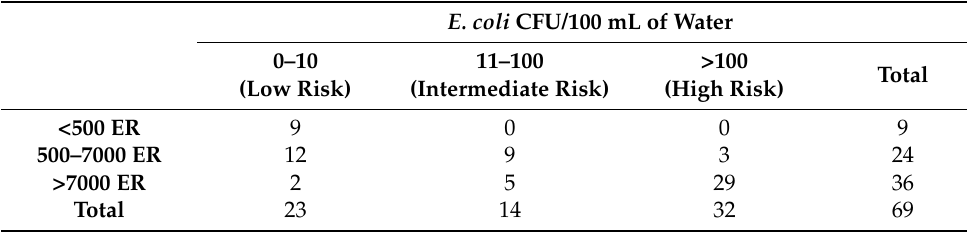
Table 1. Chi-squared analysis of E. coli (CFU/100 mL) vs. ER cut-off values from the freshwater samples presented in Figure 1. X 2 = 47.57, Degrees of freedom = 4, p -value = 0.0001.